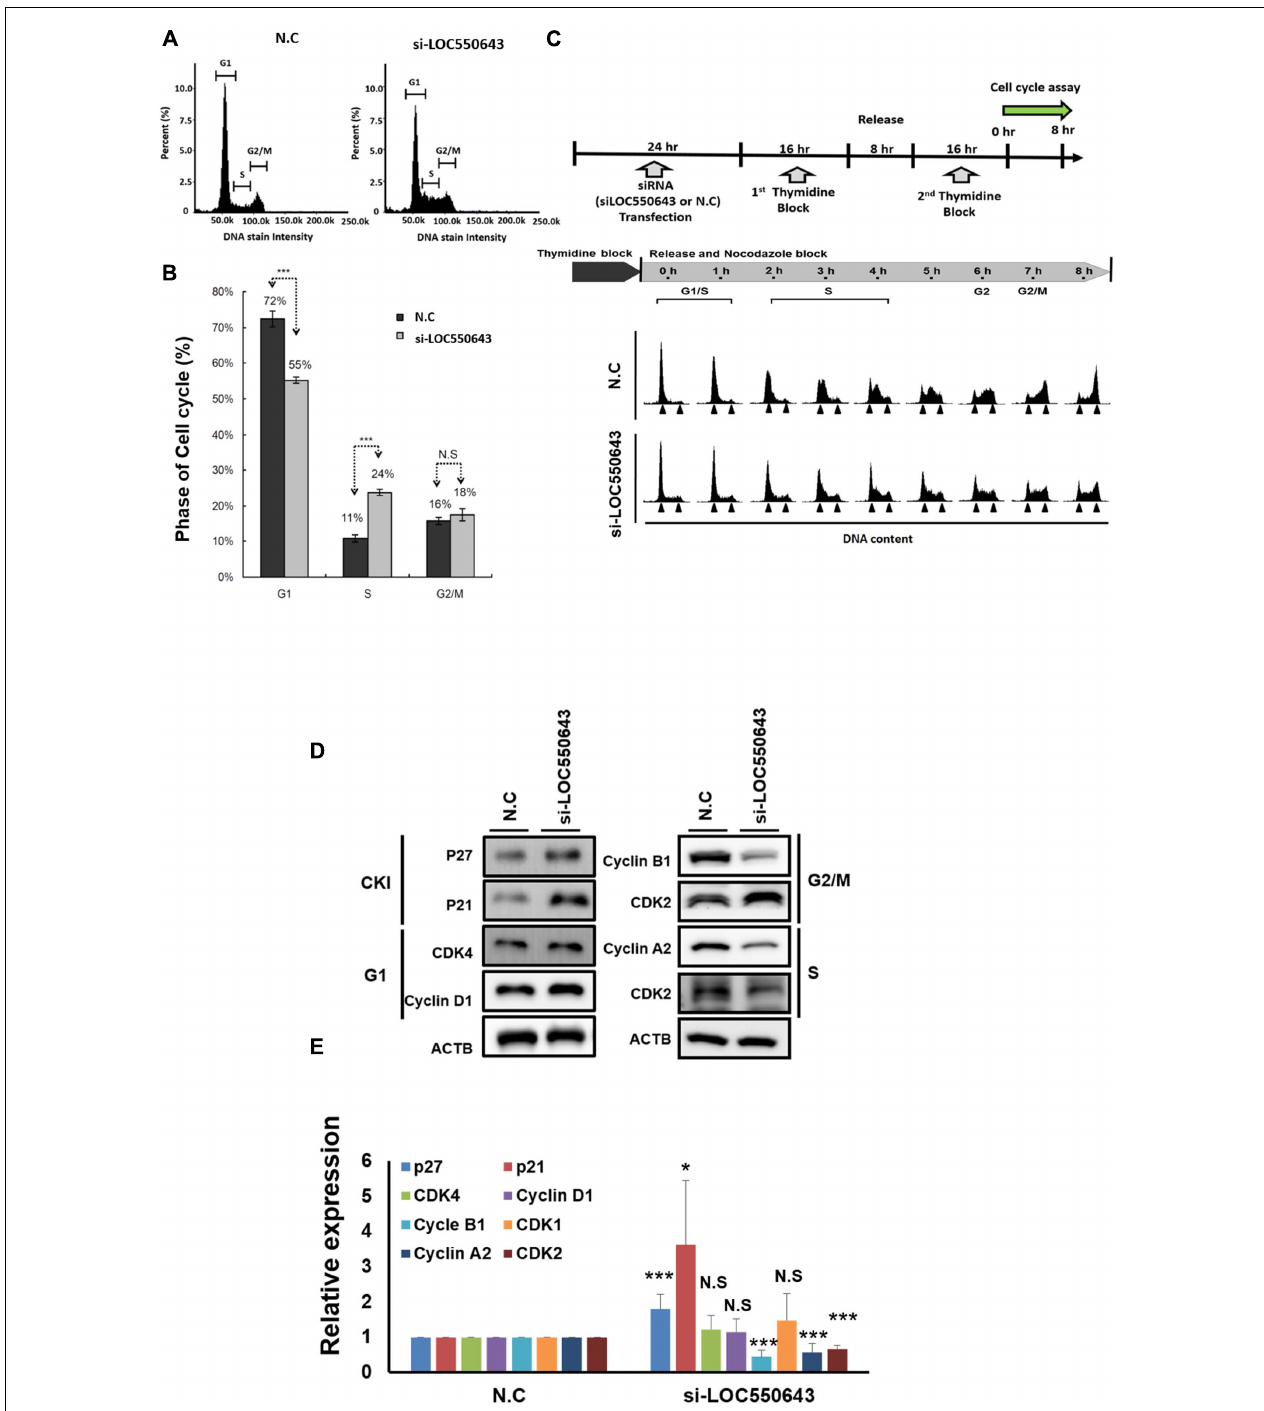
FIGURE 5 | Suppression of breast cancer cell growth through the induction of cell cycle arrest at the S phase following LOC550643 depletion. (A) Cell cycle of MDA-MB-231-IV2-1 cells after 48 h of LOC550643 knockdown. (B) Experiments were performed in triplicate and data were quantified and analyzed using Student’s t -test. (C) Cell cycle of MDA-MB-231-IV2-1 cells synchronized using a double thymidine block and released into nocodazole medium for the indicated times. At each time point, the cells were subjected to cell cycle analysis. (D) Expression levels of cell cycle–related genes examined using Western blotting assays following 48 h of siRNA transfection. (E) Western blotting assays were done in triplicate, then all experiment data were further quantified. Using Student’s t -test to analyze our data and p < 0.05 was considered significant (* p < 0.05, ** p < 0.01, and *** p < 0.001).